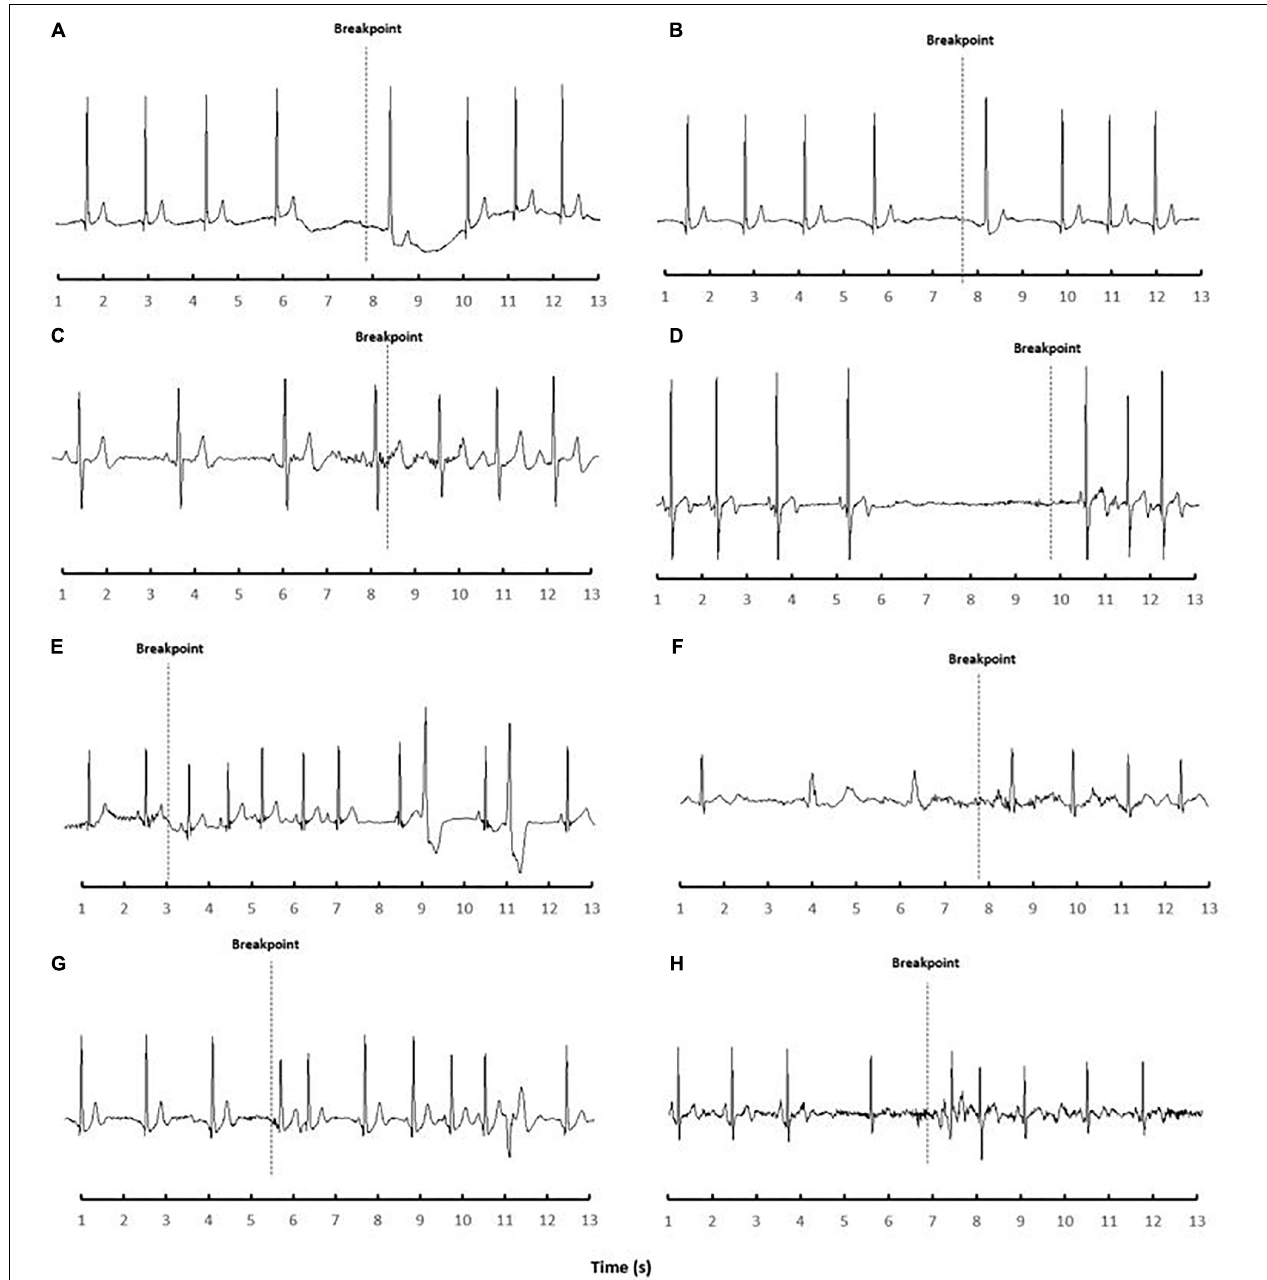
FIGURE 2 | ECG recordings of Lowlanders identified with brady-arrhythmias during apnea (N.8) at 4330 m. Each frame (A–H) represents a single participant recording obtained preceding and/or proceeding volitional breakpoint. (A) sinus pause with junctional escape following volitional breakpoint; (B) ectopic atrial rhythm with junctional escape that began prior to volitional breakpoint and continued four beats following breakpoint; (C) premature atrial rhythm around volitional breakpoint; (D) sinus pause (4.3 s) immediately preceding volitional breakpoint; (E) ventricular bigeminy following breakpoint and 1st degree heart block (developed into 3rd degree); (2F) ventricular escape rhythm prior to volitional breakpoint; (G) premature ventricular contractions developed following breakpoint; (H) sinus pause with junctional escape preceding volitional